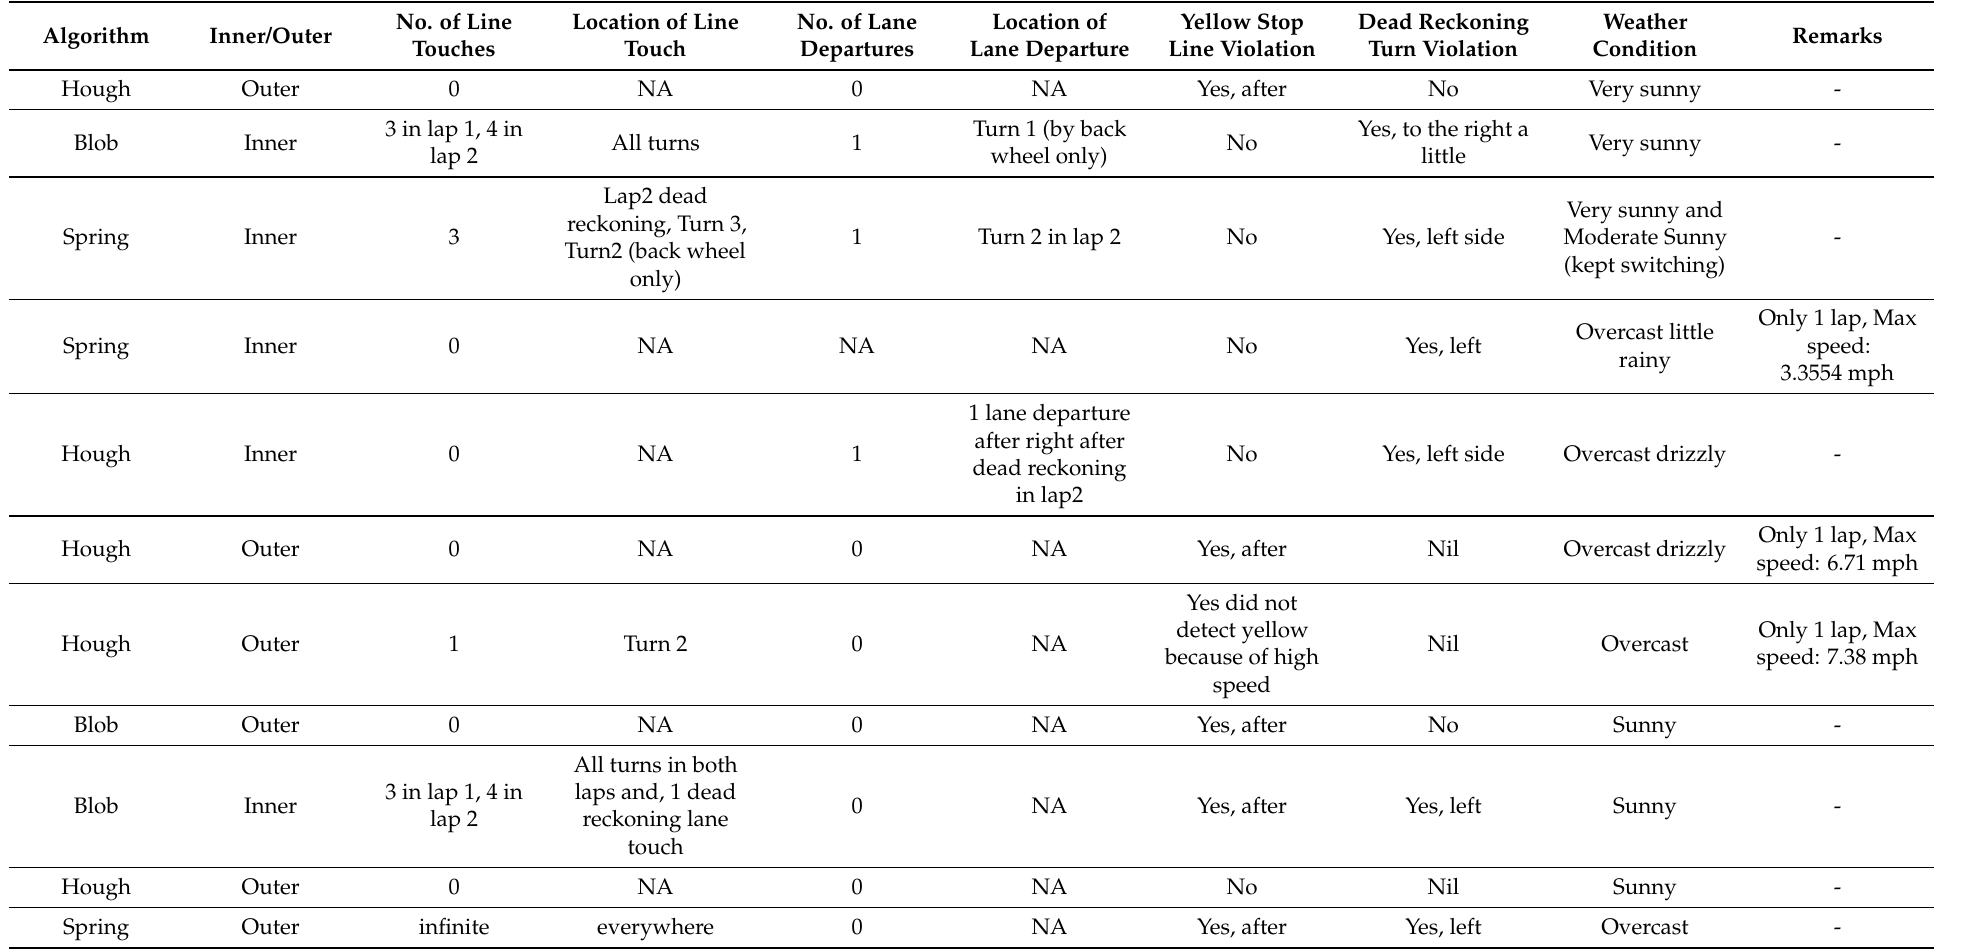
Table A3. Success Cases recorded when evaluated by a team